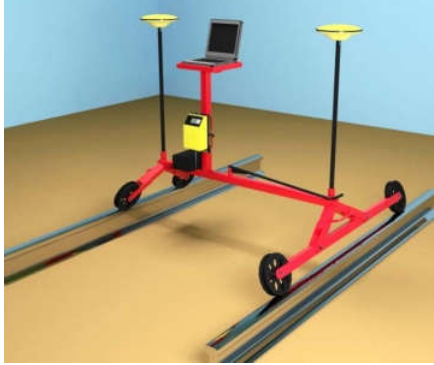
Figure 1. Hardware and software suite